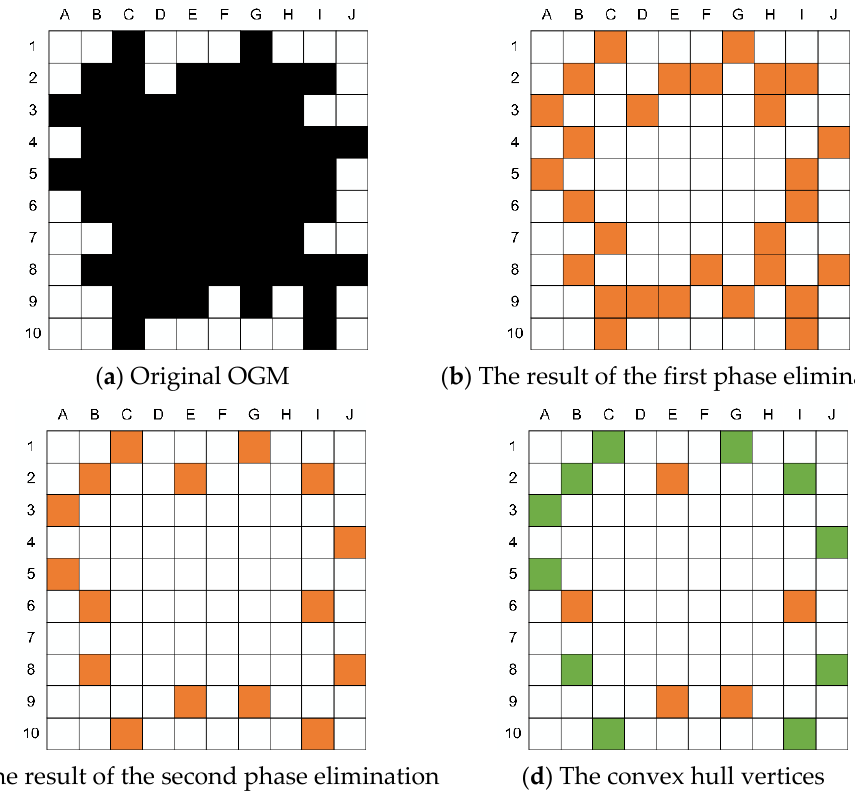
Figure 13. An example of convex hull vertices searching for irregular region.